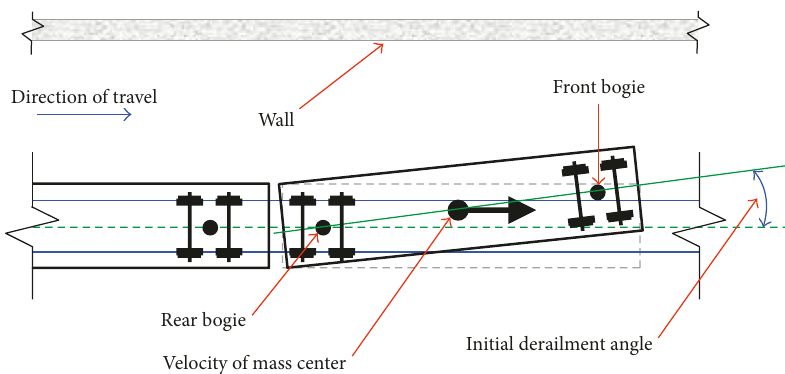
Figure 7: Initial derailment angle on